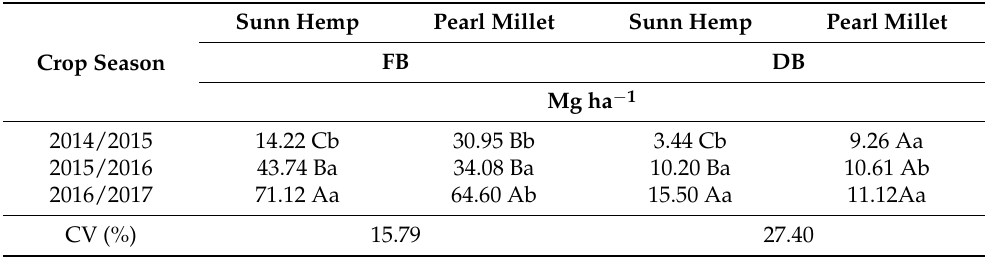
Table 4. Fresh above-ground biomass (FB) and dry above-ground biomass (DB) at the end of the crop cycle of sunn hemp and pearl millet in three consecutive crop seasons.